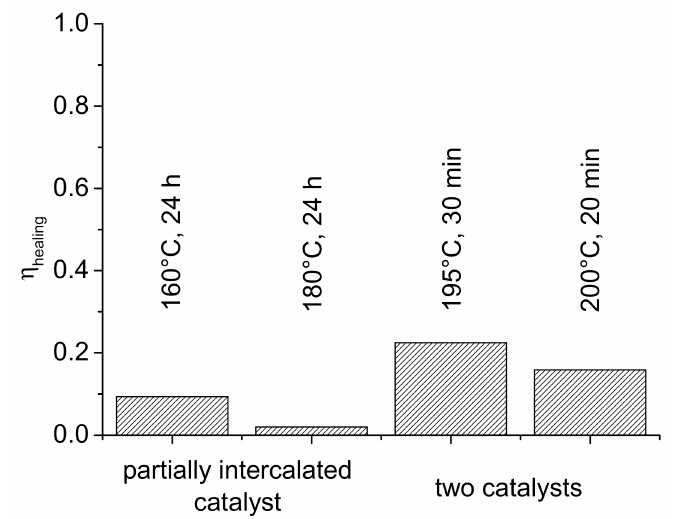
Figure 9. Total healing e ffi ciency at di ff erent healing temperatures for nanofilled toughened